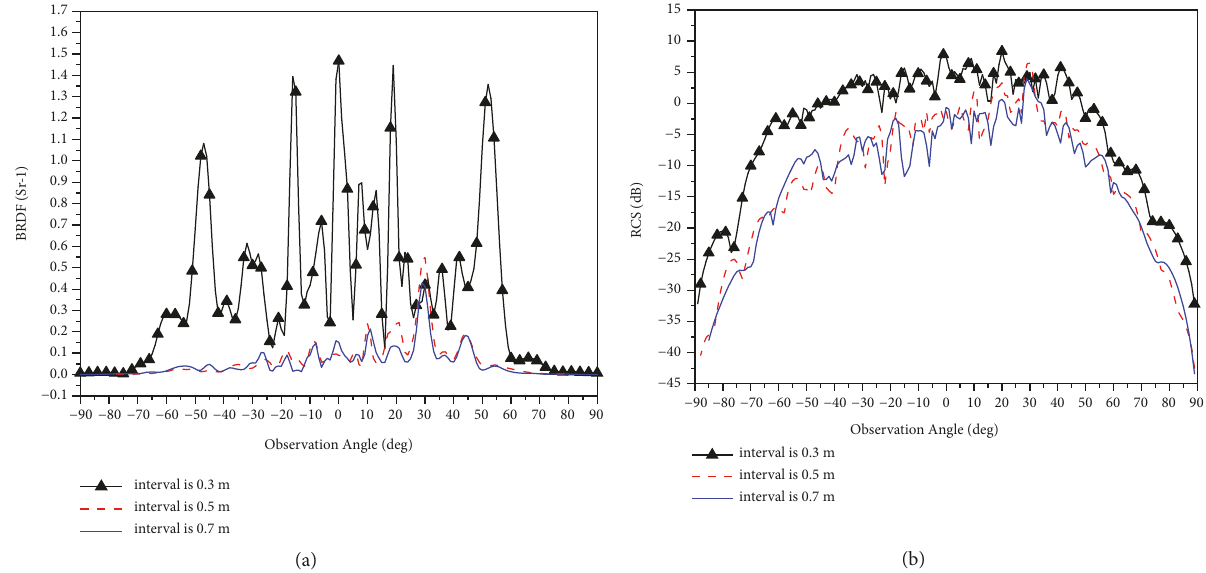
Figure 11: Relationship between scattering intensity and density of vegetation leaves. (a) BRDF with different intervals of leaves. (b) RCS with different intervals of leaves.